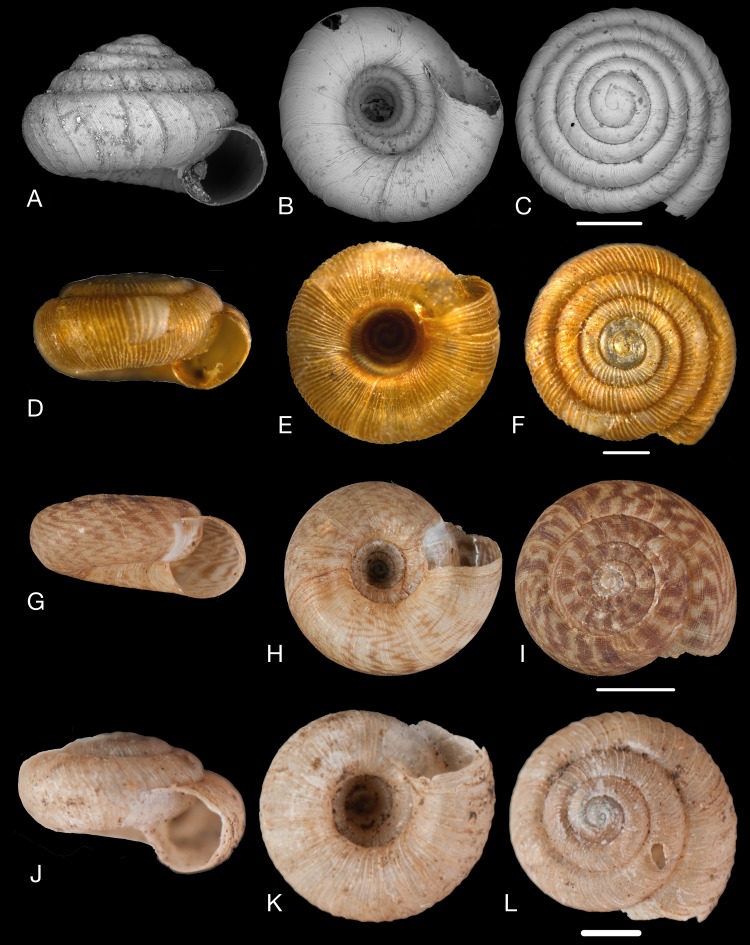
Material collected by the CCP.(A–L) Charopidae. Lilloiconcha pazi (Philippi, 1866), MNCN 15.05/76220, (A) ventral view, (B) umbilical view, (C) apical view; Ptychodon amancaezensis (Hidalgo, 1869), MNCN 15.05/3173, (D) ventral view, (E) umbilical view, (F) apical view; Stephanoda binneyana (Pfeiffer, 1847), MNCN 15.05/12956, (G) ventral view, (H) umbilical view, (I) apical view; Zilchogyra costellata (d’Orbigny, 1835), MNCN 15.05/76209, (J) ventral view, (K) umbilical view, (L) apical view. Scale line 500 µm (D–F), 1 mm (A–C), 5 mm (G–L).